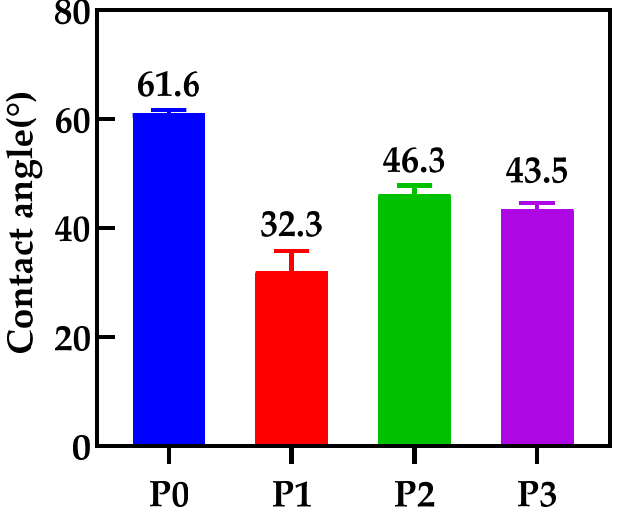
Figure 13. Contact Angle of membranes with different GO doping.